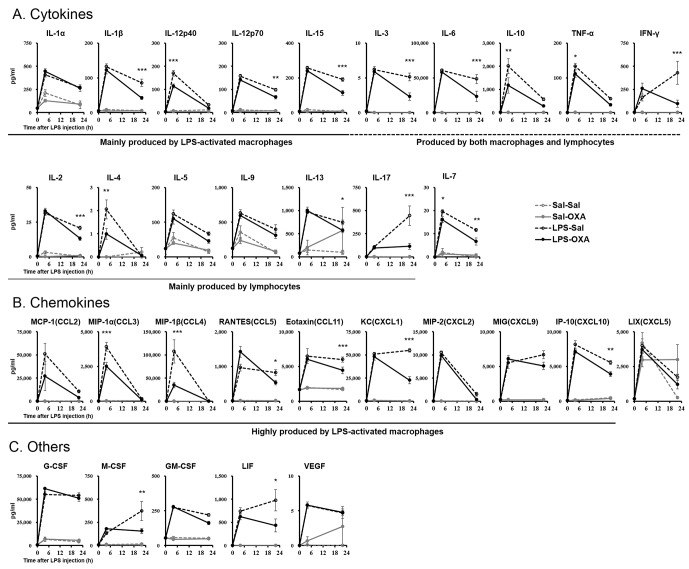
Effects of peripherally administered OXA on cytokine production in mice with endotoxin shock.Effects of OXA treatment on the levels of 32 cytokines in serum at 4 hr and 22 hr after injection of LPS (LPS-OXA) or saline (Sal-OXA), compared to saline treatment (LPS-Sal, Sal-Sal) (each group n = 8, *p<0.05, **p<0.01, ***p<0.001). OXA (1 mg/mouse/24 hr) started to be SC-administered at 30 min before LPS injection. Statistical significance assessed by 2-way ANOVA coupled with the Bonferroni’s test. Data are replicated in at least three independent experiments.